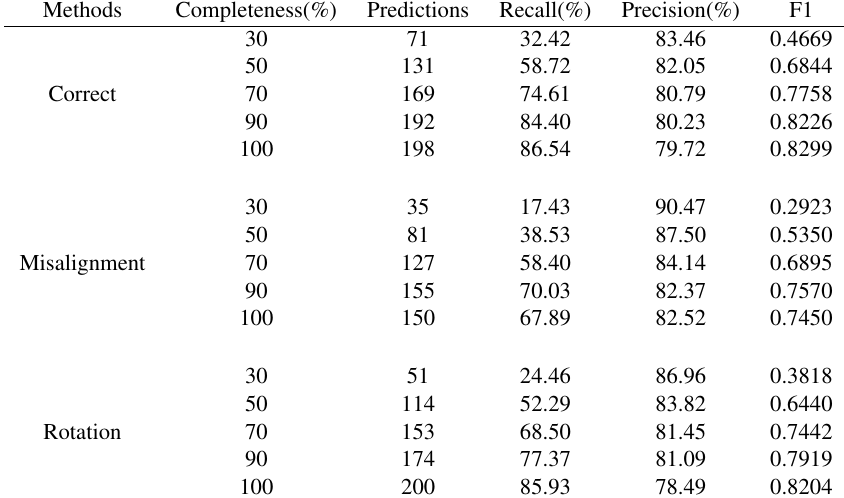
Table 1. Validation accuracies of the OSM missing building detection in Mozambique regarding different error sources in training data.